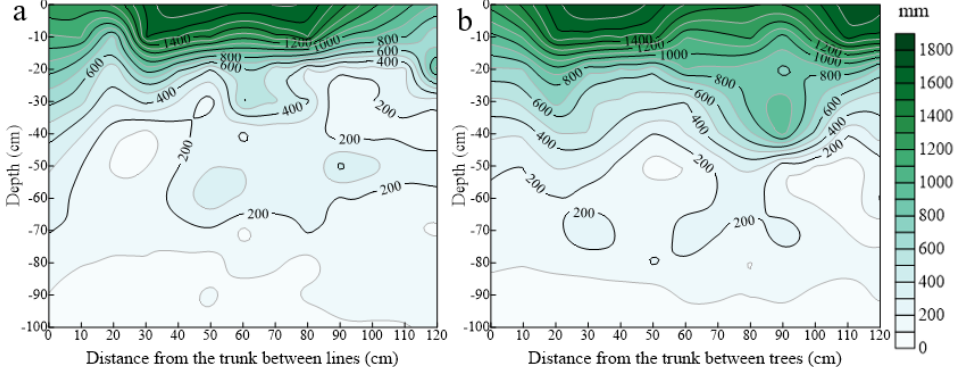
Figure 5. Contour map of root distribution in the soil from the top to 100 cm depth: ( a ) between rows and ( b ) between trees within the row in October 2016.